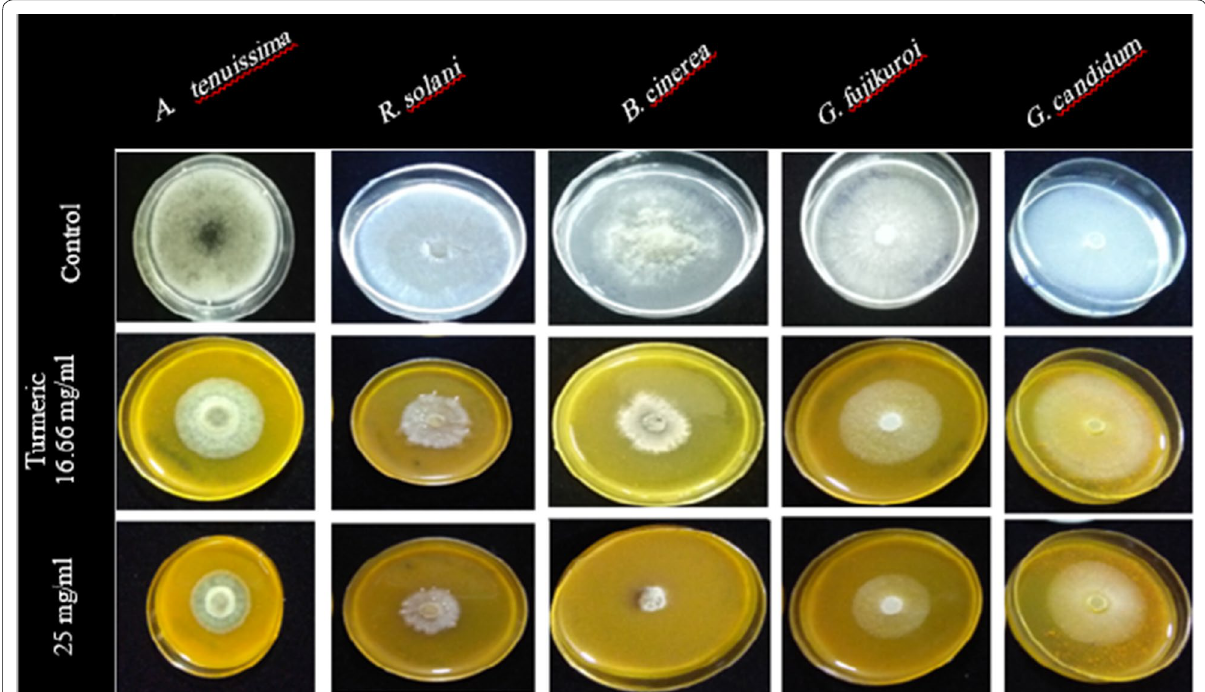
Fig. 2 Antifungal effects of turmeric extract against different plant pathogenic fungi under in vitro